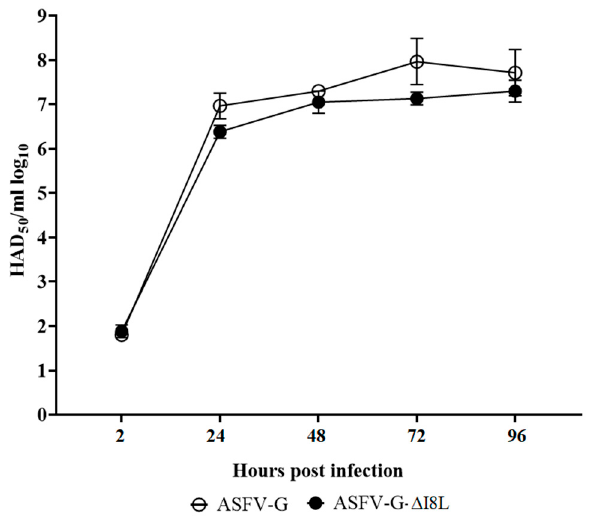
Figure 3. In vitro growth characteristics of ASFV-G- ∆ I8L (filled symbols) and parental (empty symbols) ASFV-Georgia (ASFV-G). Primary swine macrophage cell cultures were infected (MOI = 0.01) with each of the viruses, and virus yield was titrated at the indicated times post-infection. Data represent means and SD from three independent experiments. Sensitivity of virus detection: >1.8 log 10 HAD 50 /mL.